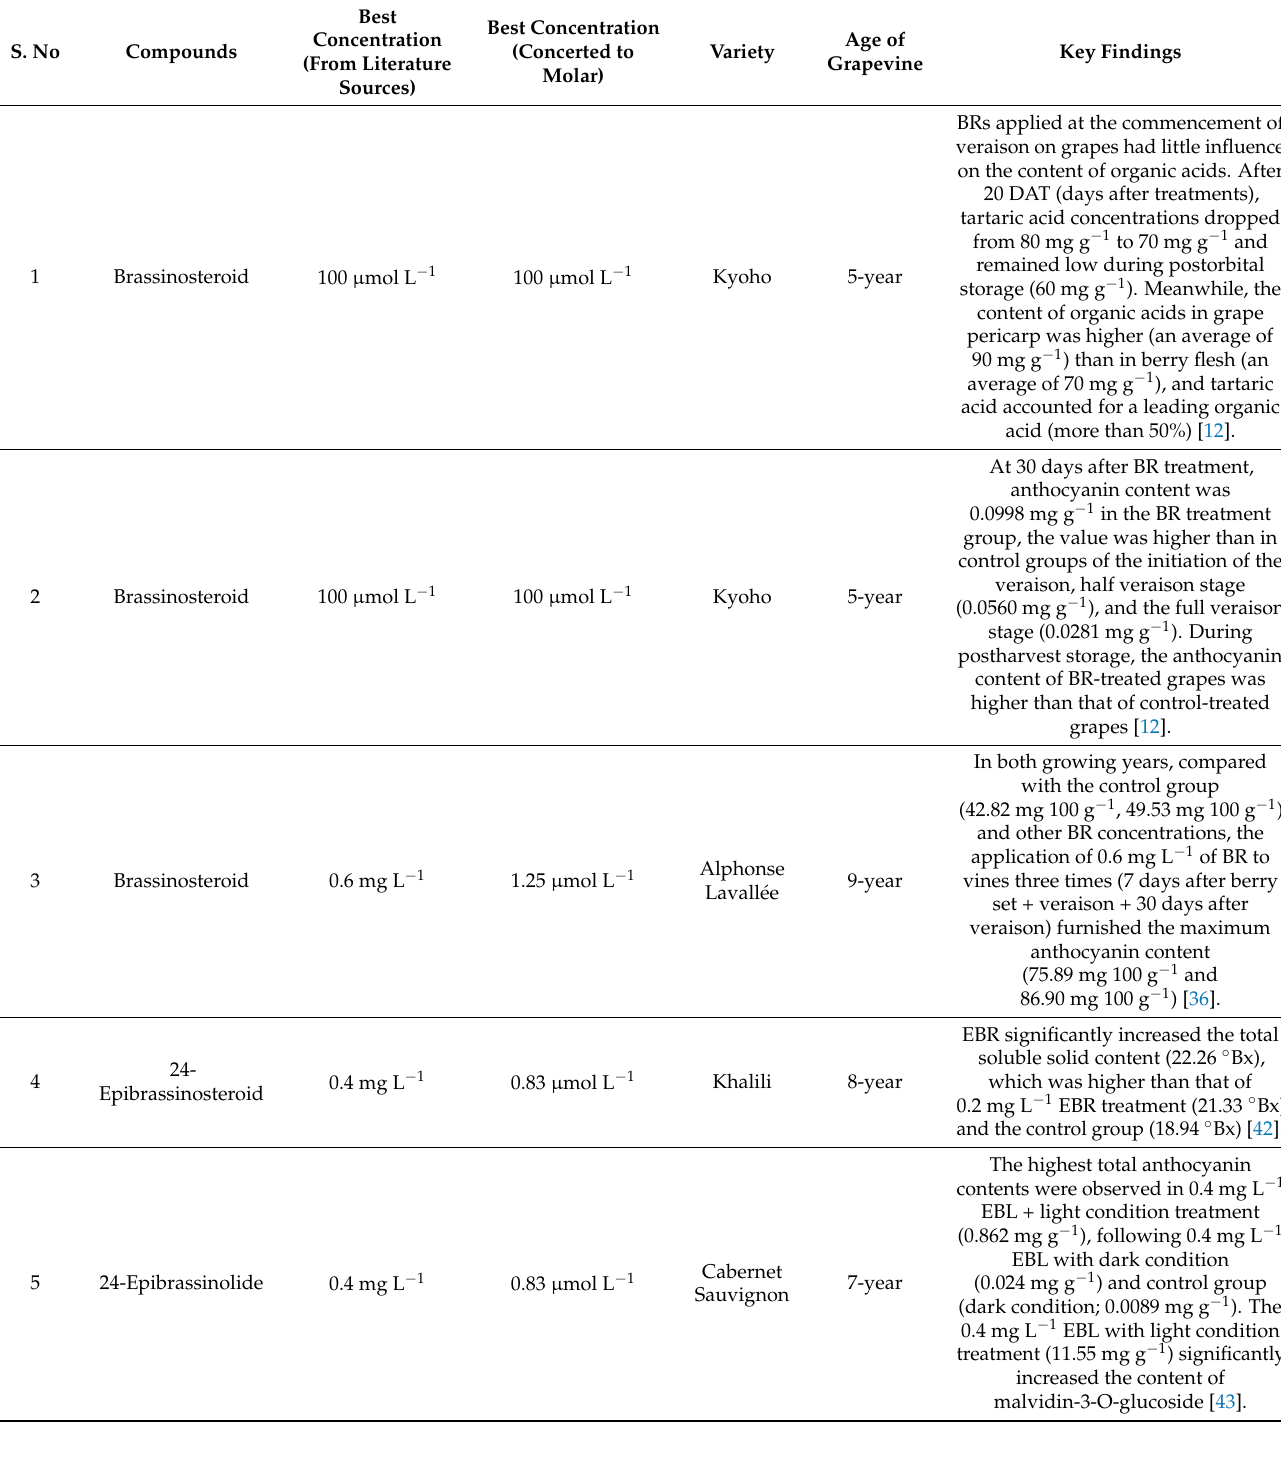
Table 2. Effect of exogenous brassinosteroid/brassinolide on biochemical properties of